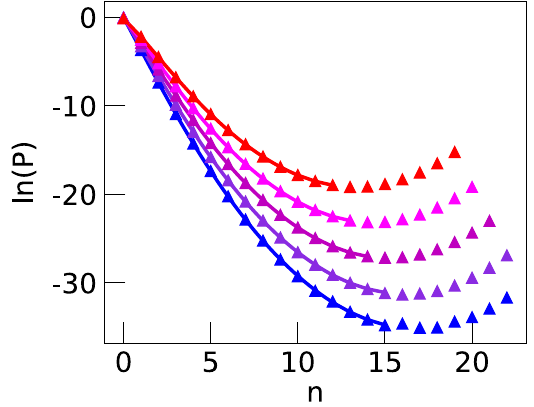
FIG. 6. The probability of being at state n , calculated from the metastable approximation [Eq. (12), line] and the simulation (triangles) for the nominal parameter set and electric fields of 180, 200, 220, 240, and 260 MV = m (from bottom to top). Here we chose n c þ 7 as an absorbing state, to clearly demonstrate the minimum at n ¼ n c , see Appendix